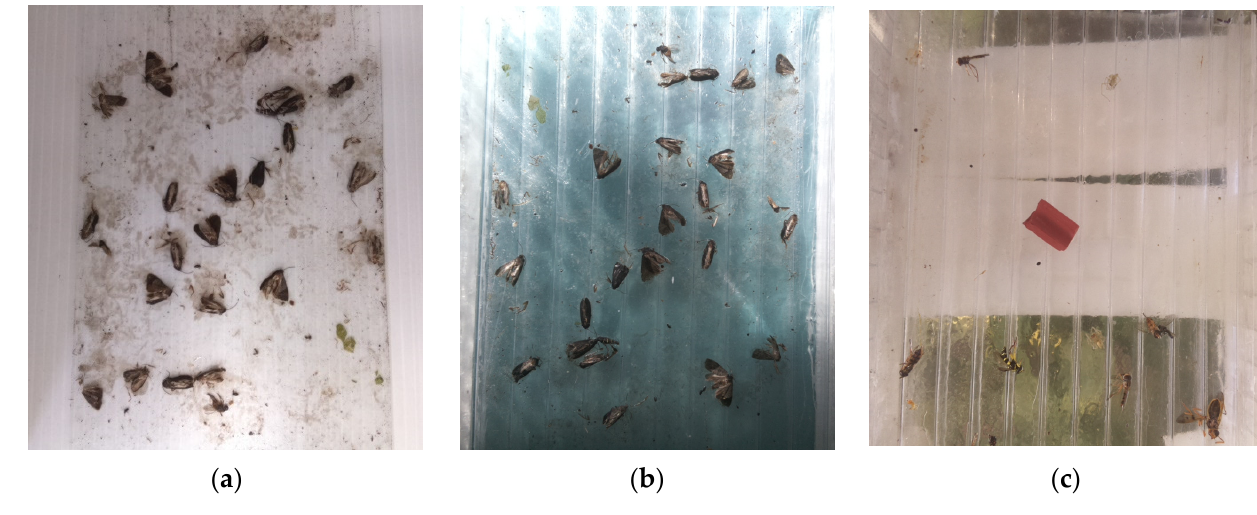
Figure 1. Sticky papers with captured moths ( a,b ), and without moth ( c ).